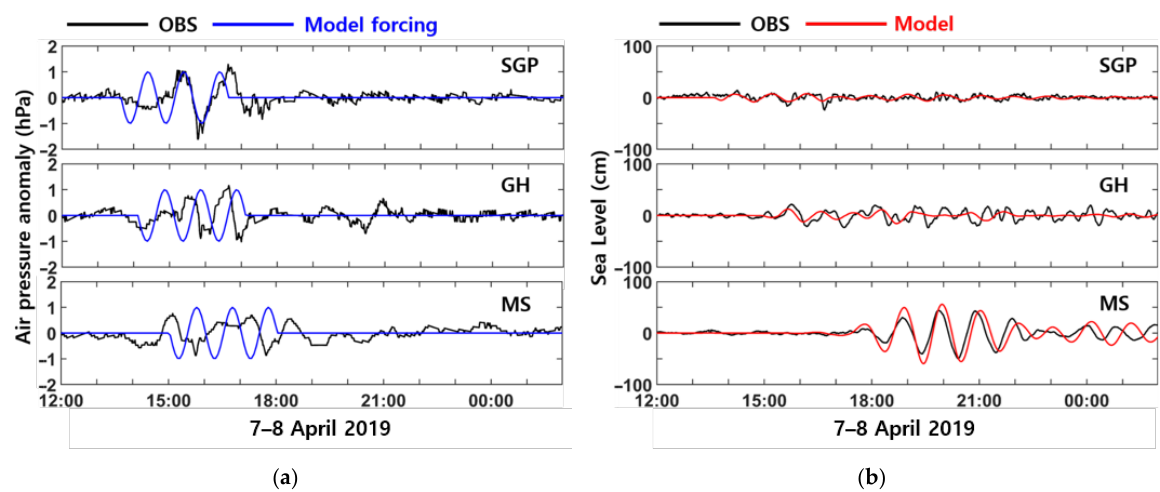
Figure 6. Comparison of ( a ) atmospheric pressure anomalies and ( b ) sea level variations from observations and numerical simulations at SGP, GH, and MS from 12:00 on 7 April to 06:00 on 8 April 2019.